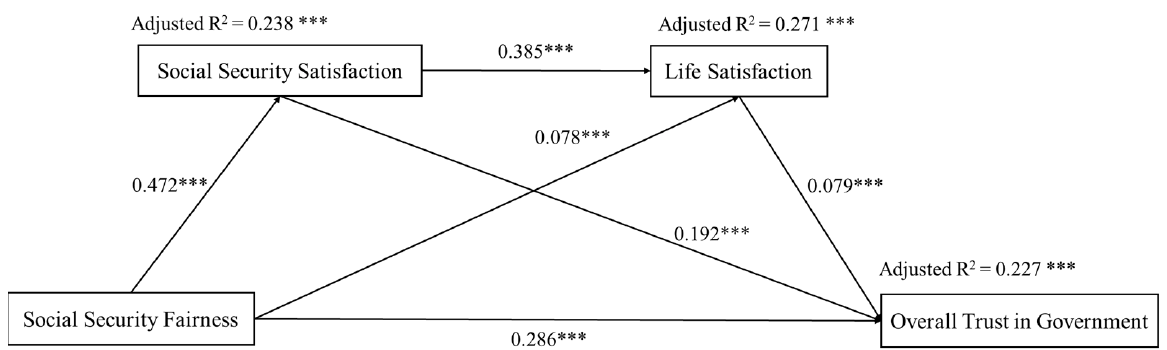
Figure 1. The serial mediator model of social security fairness, social security satisfaction, life satis- faction, and overall trust in government after adding the control variables ( n = 7403). Standardized regression coefficients are shown next to the arrows. Adjusted R 2 is shown above the explained variable. *** p < 0.001.